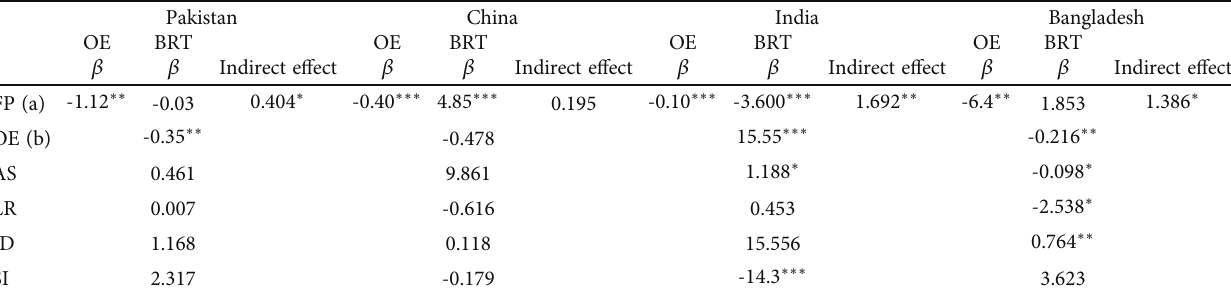
Table 6: Country-wise path analysis